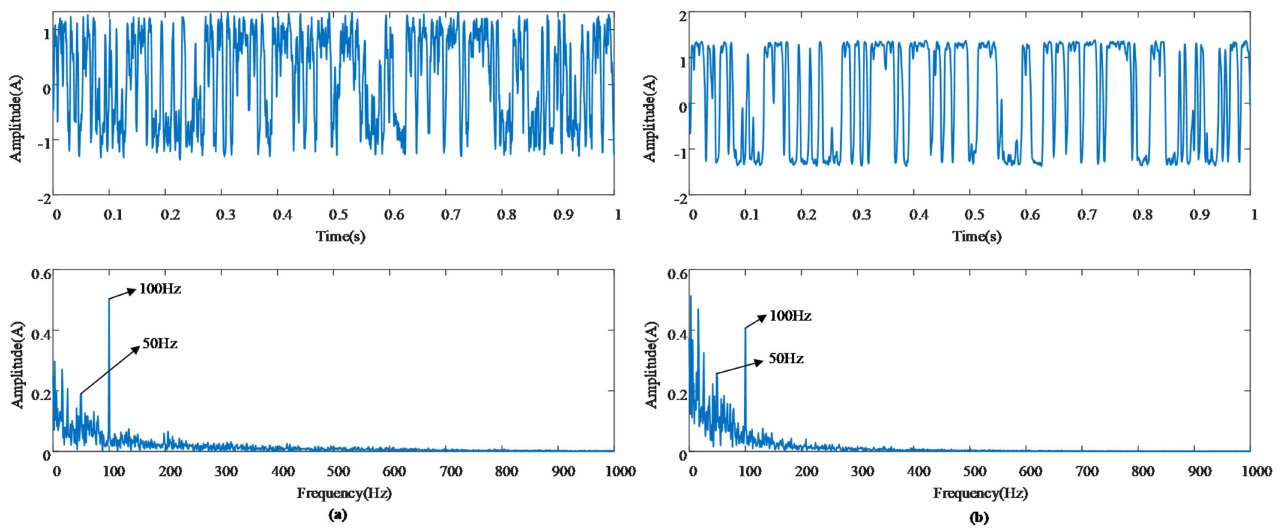
Figure 6. Time − frequency domain waveform after noise reduction by high-pass filtering.